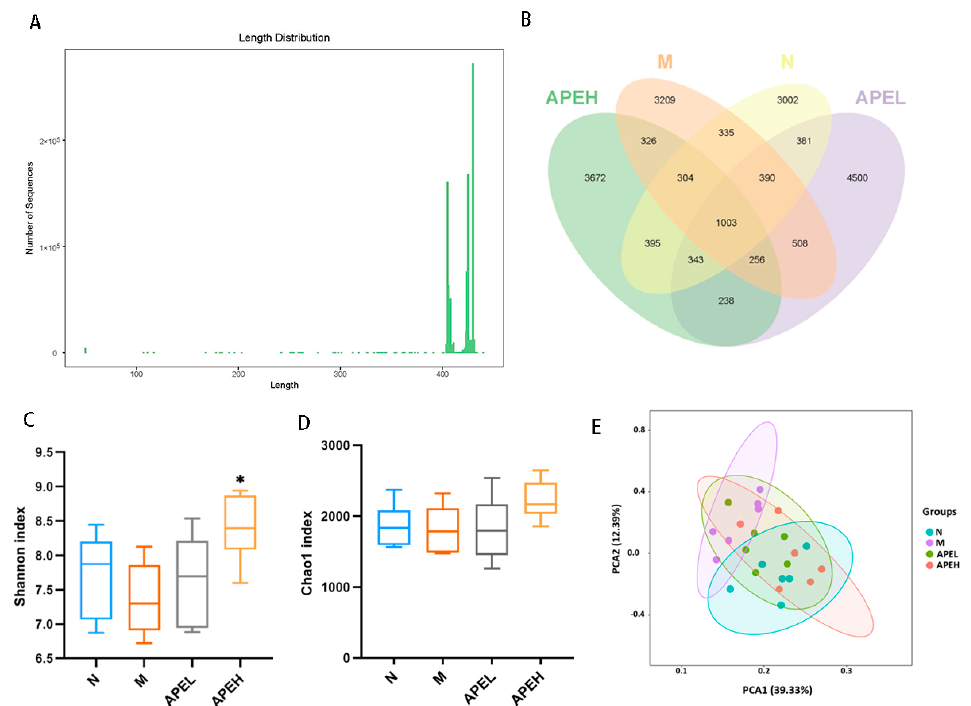
Figure 4. Effective sequence length distribution of intestinal microbial sequence tags in mice ( A ); Venn diagram of OTU distribution in the normal, model, APEL, and APEH groups ( B ); α diversity indicated by the ( C ) Shannon index and ( D ) Simpson index; PCA plots were used to visualize differences in weighted UniFrac distances of samples of OTUs from different groups ( E ). ((*) p < 0.05 compared to the model group). (N, normal group; M, model group; APEL, 150 mg/kg APE group; APEH, 300 mg/kg APE group).